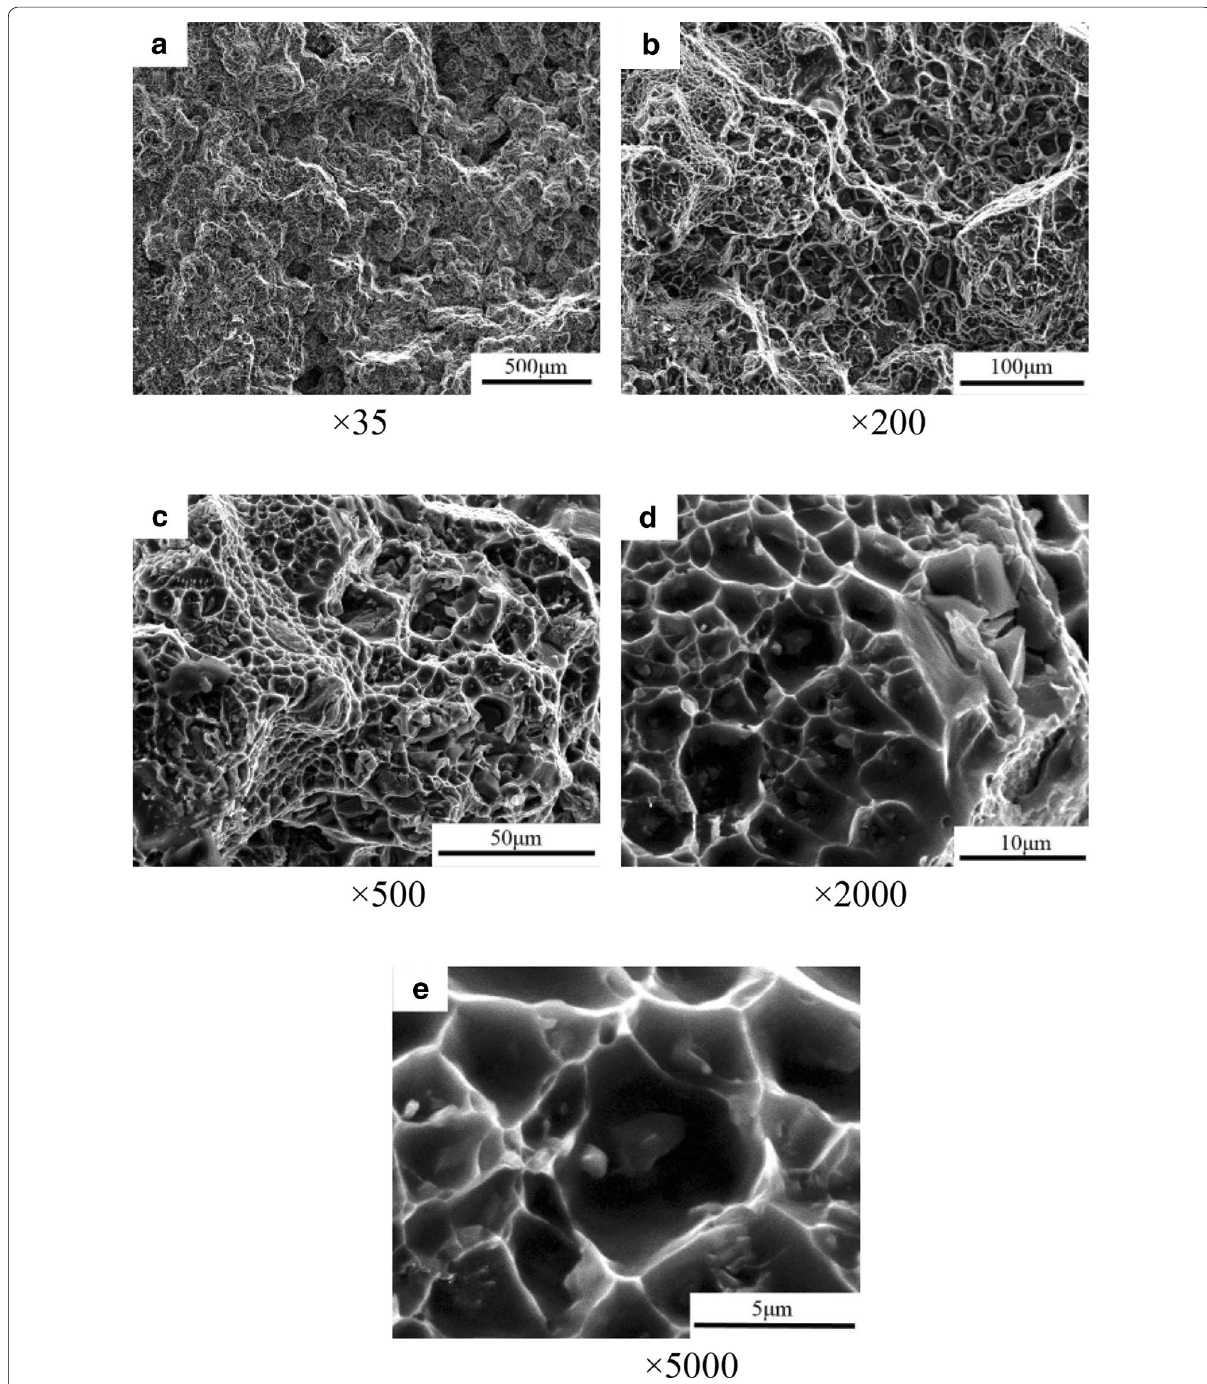
Figure 4 Fracture morphology of T6 treated alloy under different